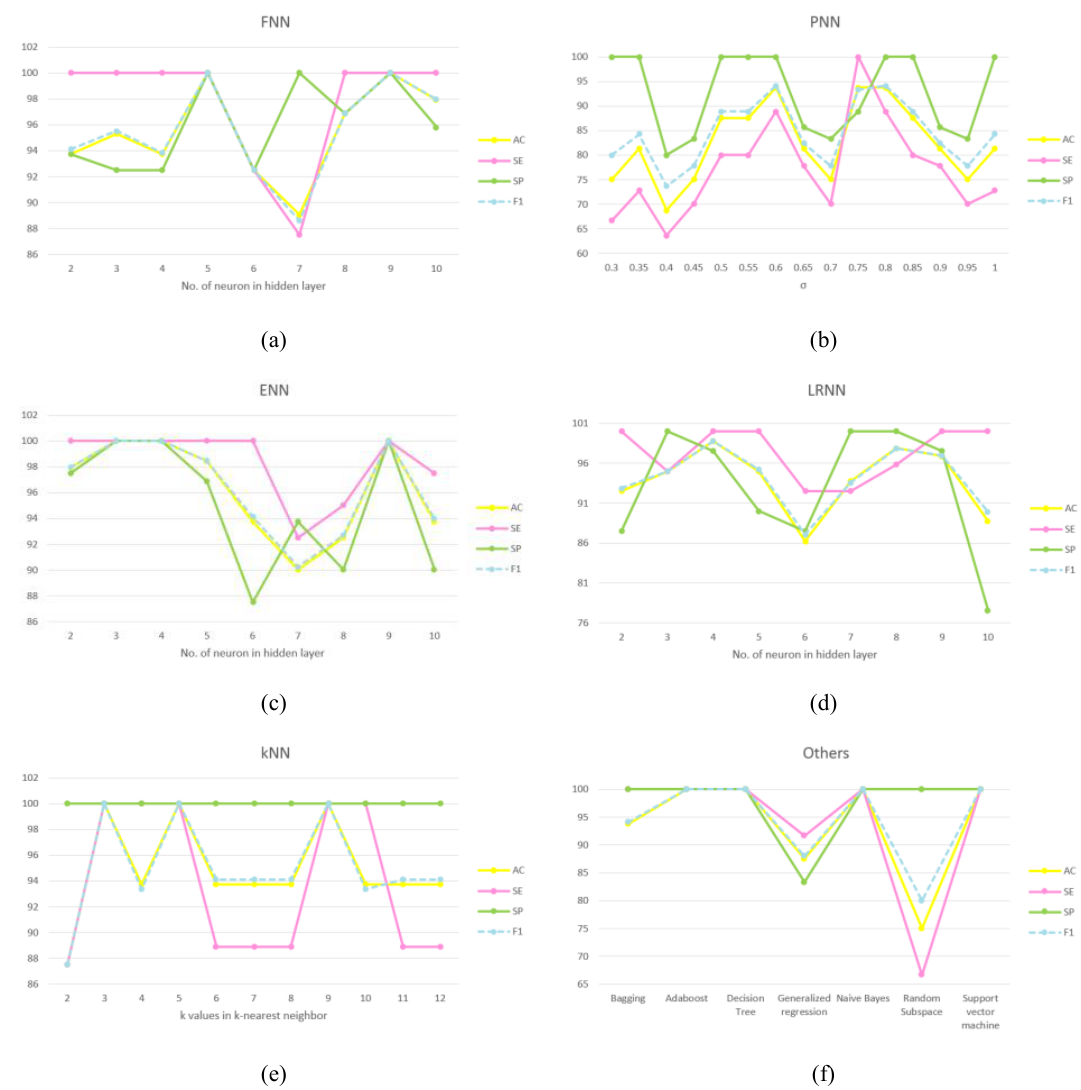
Figure 4. The Performance of Different ML Schemes in Discrimination Between COPD and Controls Using 5-Fold CV: (a) FNN, (b) PNN, (c) ENN, (d) LRNN, (e) kNN, and (f) other remaining approaches including DT, EMs, GRNN, SVM, and NB. Note . ML: Machine learning; COPD: Chronic obstructive pulmonary disease; CV: Cross-validation; FNN: Feed-forward neural network; PNN: Probabilistic neural network; ENN: Elman neural network; LRNN: Layer recurrent neural network; kNN: k-nearest neighbor; DT: Decision tree; EM: Ensemble method; GRNN: Generalized regression neural network; SVM: Support vector machine; NB: Naive